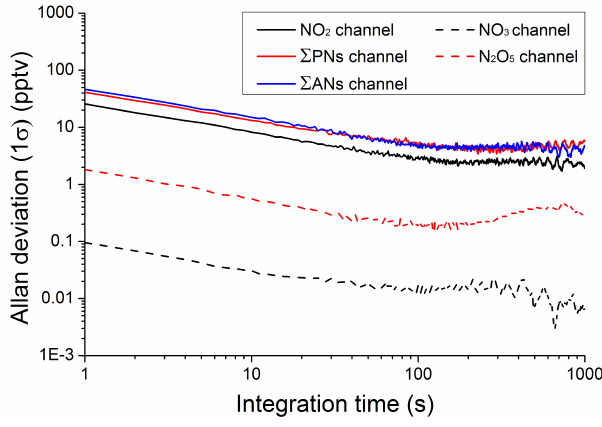
Figure 3. Allan deviation plot (1 σ ) for each of the five CRDS chan- nels. The data were obtained in the laboratory at ≈ 298K and a cavity pressure of 800mbar.